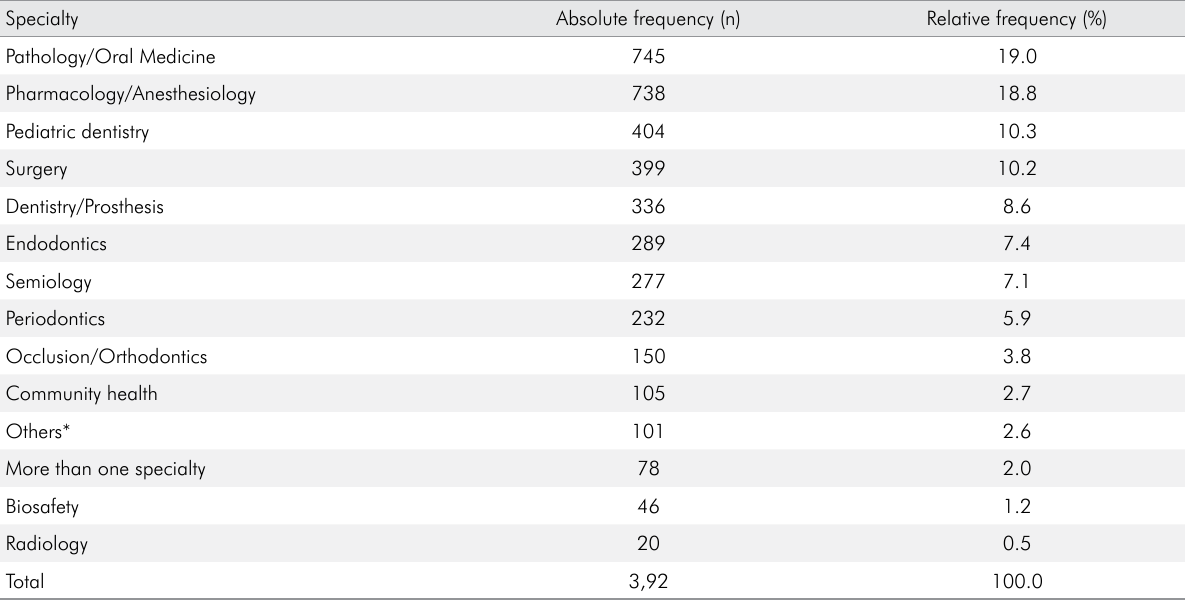
Table 3. Descriptive analysis of dental teleconsulting sessions according to specialty in Minas Gerais, Brazil,